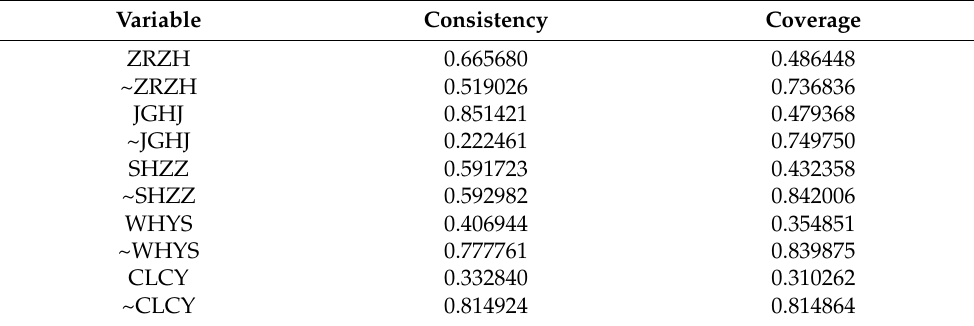
Table 7. Necessary conditions for each causal variable (~BHFZ, low-level protection and develop- ment).